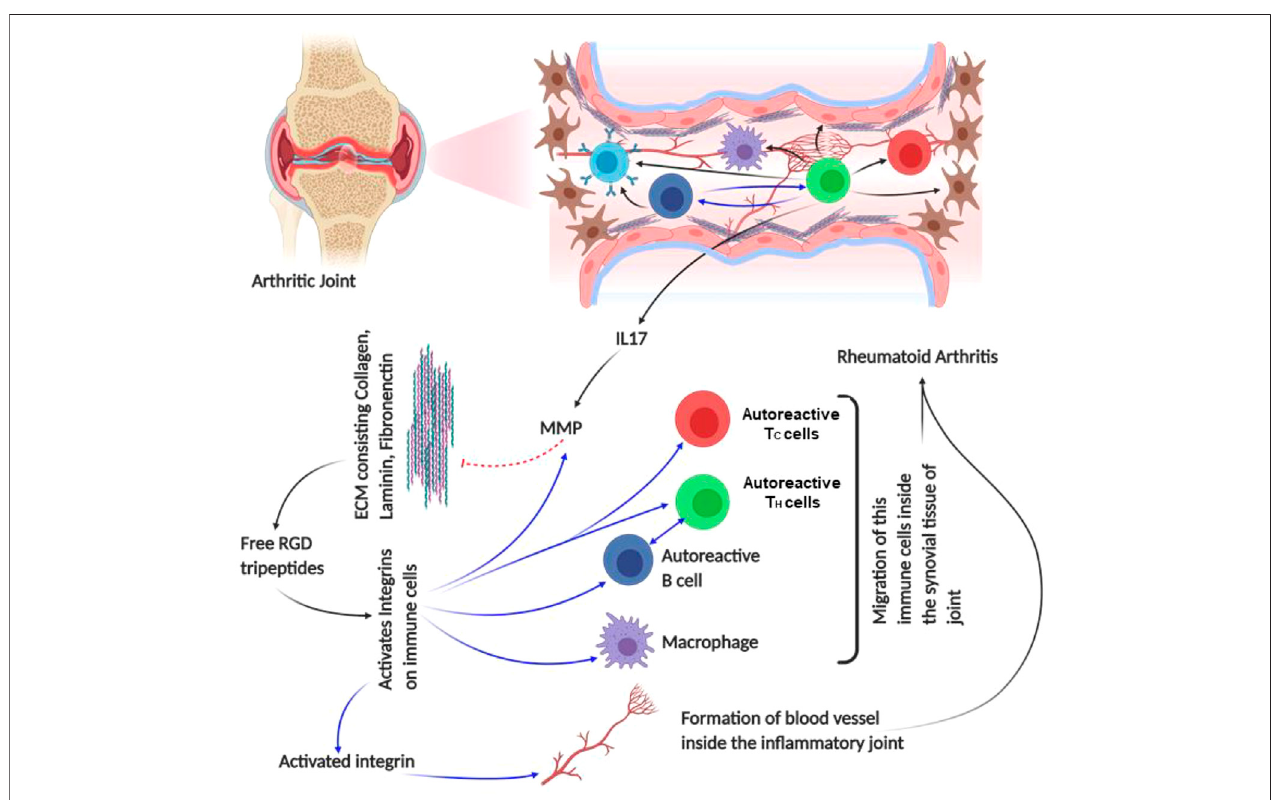
FIGURE 5 | Schematic diagram of rheumatoid arthritis pathophysiology: the fi gure provides a schematic diagram of how rheumatoid arthritis develops and what points of this disease are regulated by integrin. Blue arrows denote signaling/mechanism being regulated by integrin.